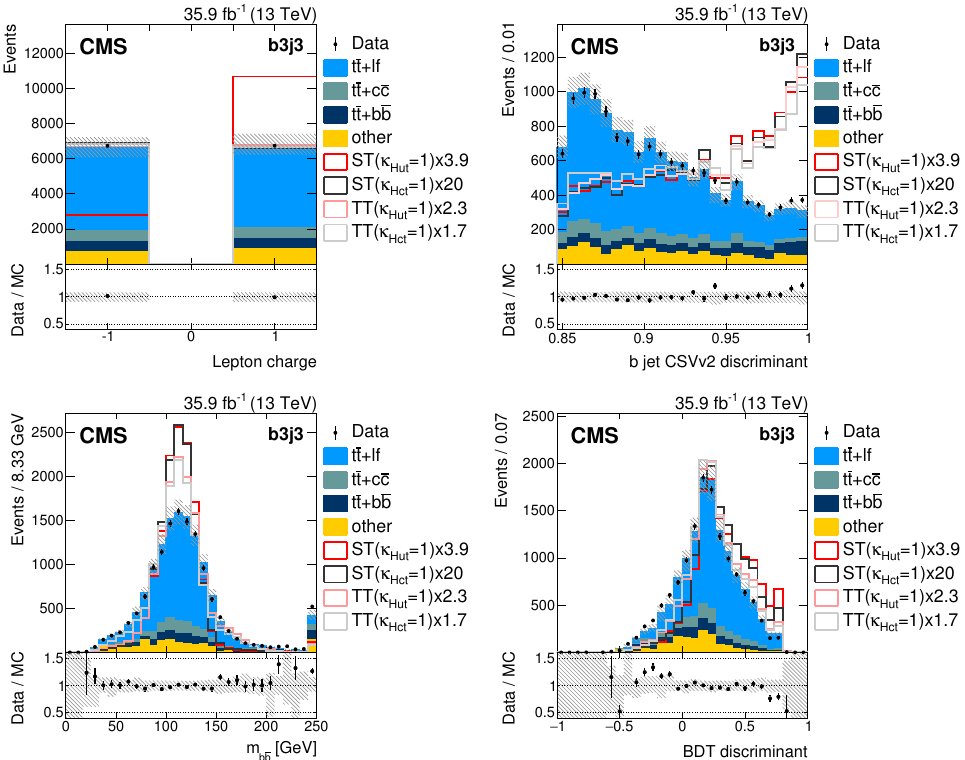
Figure 2 . Comparison between data and simulation for the most discriminating BDT input vari- ables in the b3j3 category: lepton charge (upper left), CSVv2 discriminant value for one of the reconstructed b jets assigned to Higgs boson decay (upper right), reconstructed invariant mass of two b jets associated with the Higgs boson decay (lower left), and the maximum BDT discriminant value from the b jet assignment procedure (lower right). The last bin in the distribution for the reconstructed mass of the Higgs boson includes the over(cid:13)ows. The shaded area corresponds to the total uncertainty in the predicted background. The data-to-simulation ratio is also shown. The distributions for the signal processes are normalized to the total number of events in the predicted background to ease the comparison of the shapes of the